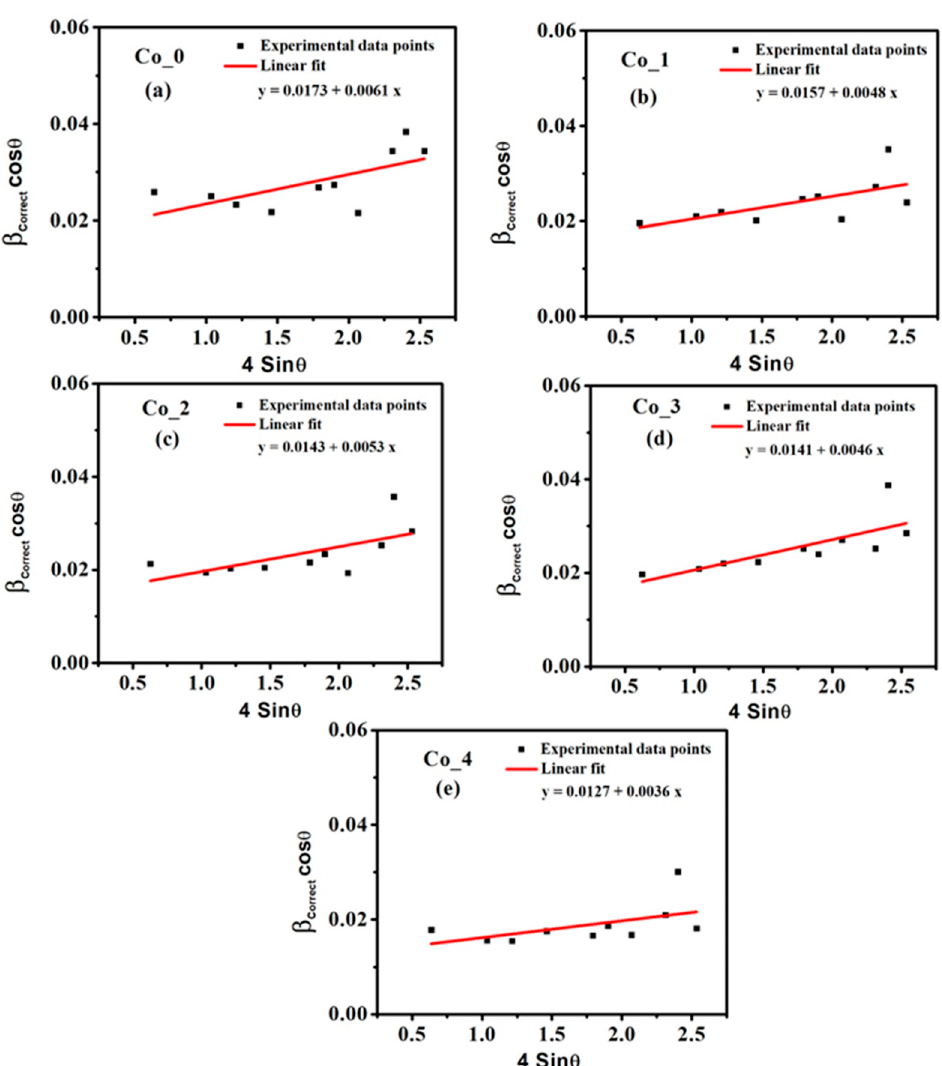
Figure 2 . The Williamson–Hall (W–H) plots for the present CoxZn1-xFe2O4 ferrite systems ( a ) x = 0.00, ( b ) x = 0.10, ( c ) x = 0.20 and ( d ) x = 0.30, ( e ) x = 0.40.